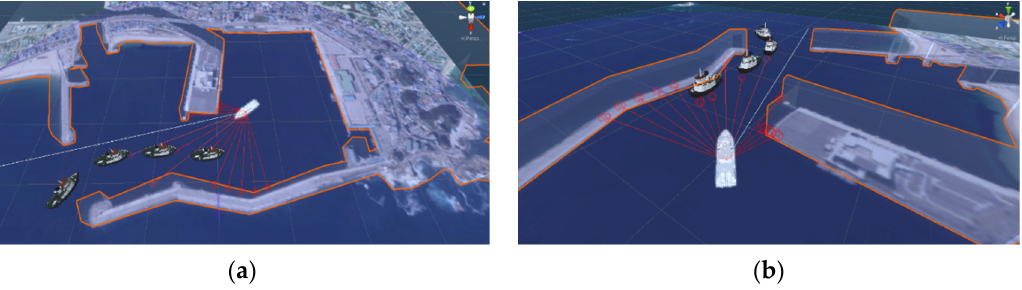
Figure 5. ( a ) 3D environment with the height added based on the 2D map on the actual harbor. ( b ) Adjustment of the ship size for the LiDAR simulation on the